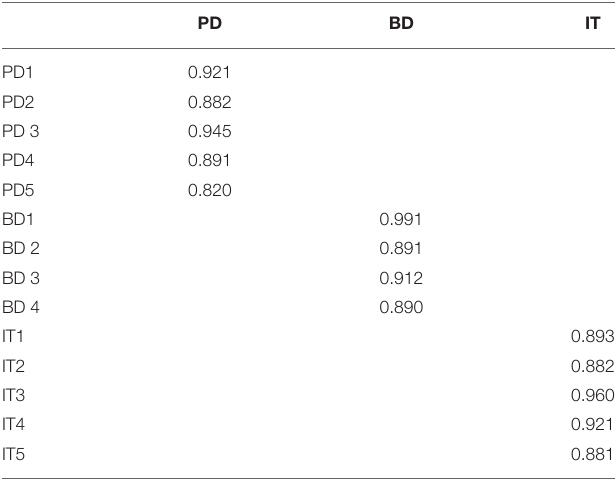
TABLE 4 | Validating the instrument used in the study. PD BD